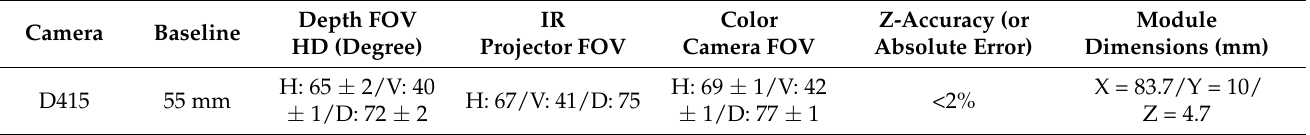
Figure 3. Different three-dimensional (3D) cameras. Left: time-of-flight camera. Middle: structured-light camera. Right: depth-from-stereo camera. Table 2. The basic parameters of the Intel RealSense D415